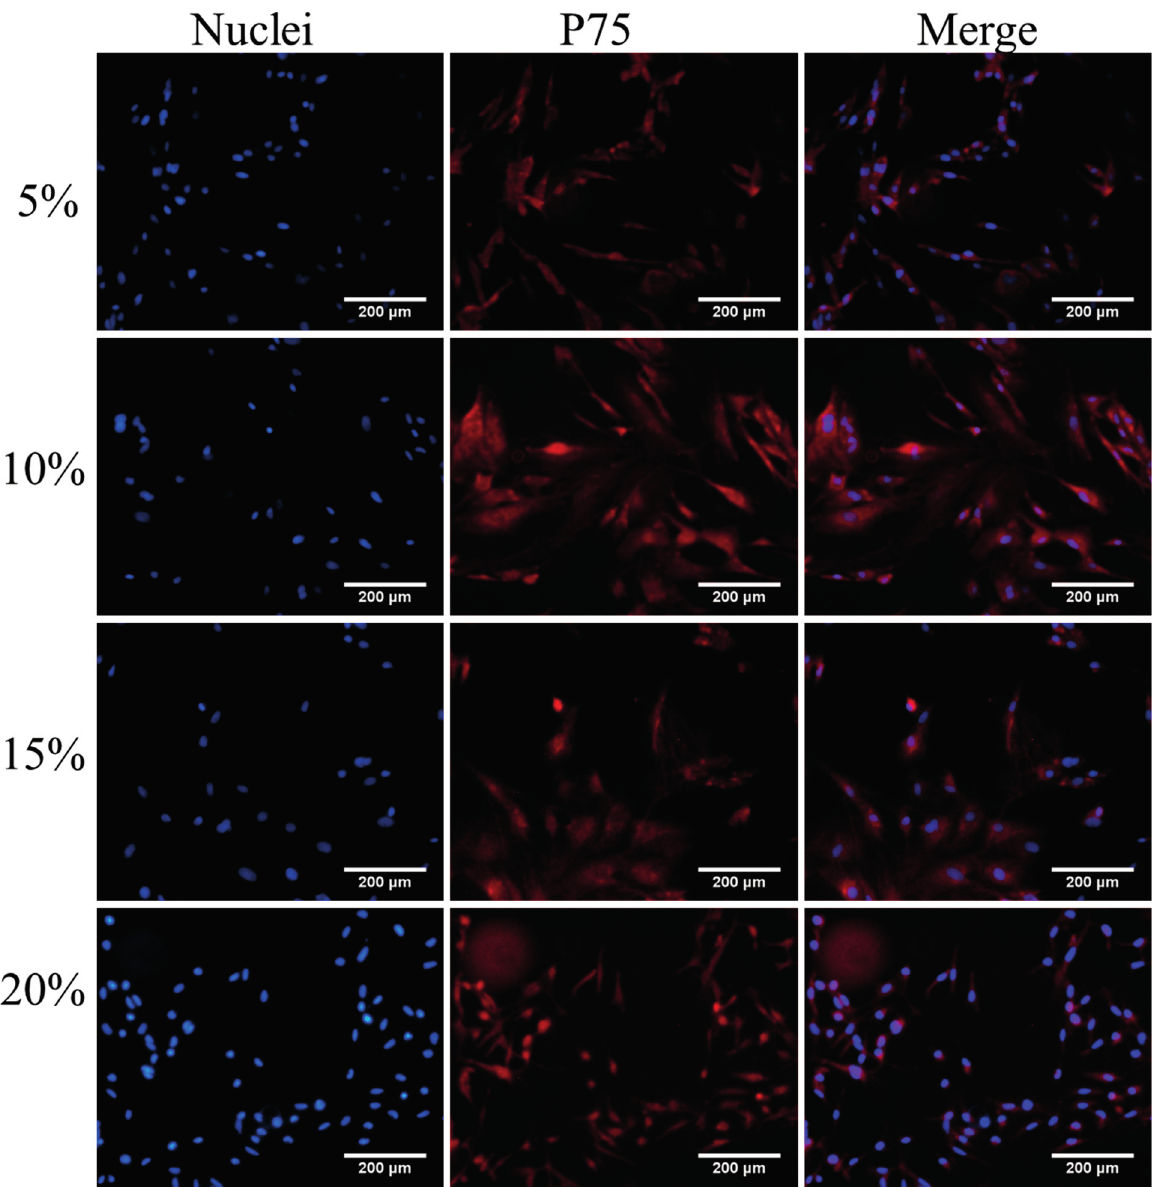
Figure 4. Immunofluorescence staining of OEC first cultured in DF-12 medium containing FBS (concentrations: 5%, 10%, 15%, 20%) for 3 days and then cultured in DF-12 medium containing RS (concentrations: 5%, 10%, 15%, 20%) for 4 days. The different concentrations of serum are listed on the left, and the concentrations of FBS and RS in one group were the same. OEC nuclei stained with DAPI are presented in the left column, P75 of OEC stained with Cy3 are presented in the middle column, and the right column is the merged nuclei and P75. Scale bar is 200 μ